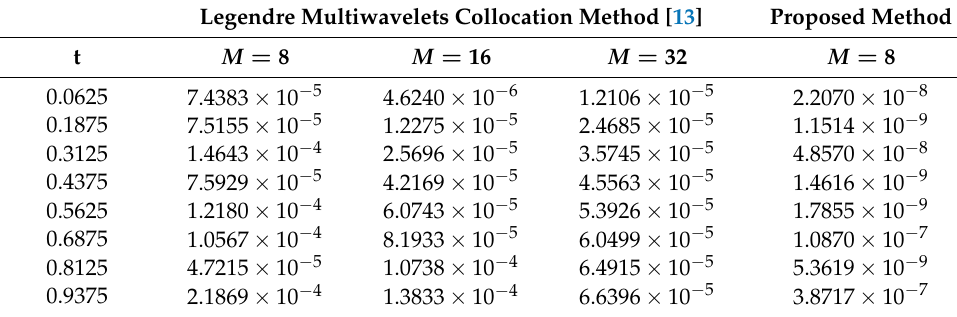
Table 1. Comparison of the maximum absolute errors at different times for Example 1.